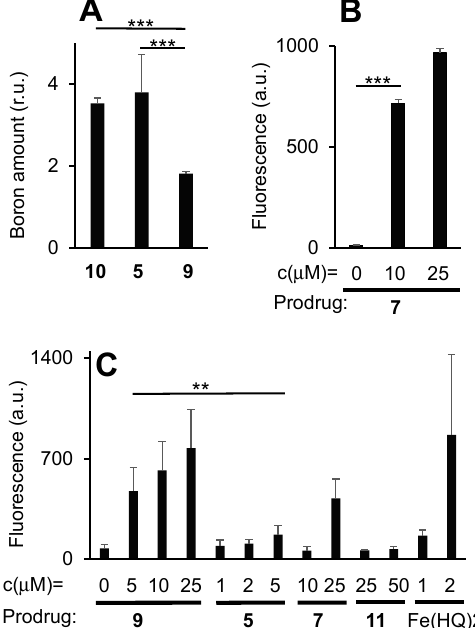
Figure 3. A : Accumulation of prodrugs 5 , 9 and 10 (each 1 μ M, incubation time- 1 h, temperature- 37 °C) in Burkitt’s lymphoma BL-2 cells monitored by analysis of the intracellular concentration of boron (Table S3, SI). B : Uptake of fluorescent prodrug 7 (0–25 μ M, incubation time—2 h, temperature—37 °C) by BL-2 cells monitored by flow cytometry ( λ ex = 488 nm, λ em = 530 nm). C : Monitoring ROS-release in BL-2 cells (using 5(6-)chloromethyl-2 ′ ,7 ′ -dichlorodihydrofluorescein diacetate as a fluorogenic probe, 10 μ M) in the presence of prodrugs 5 , 7 , 9 as well as controls 11 (negative control) and a mixture of FeCl 3 with 8-hydroxyquinoline (HQ) with a molar ratio of components correspondingly 1 to 2